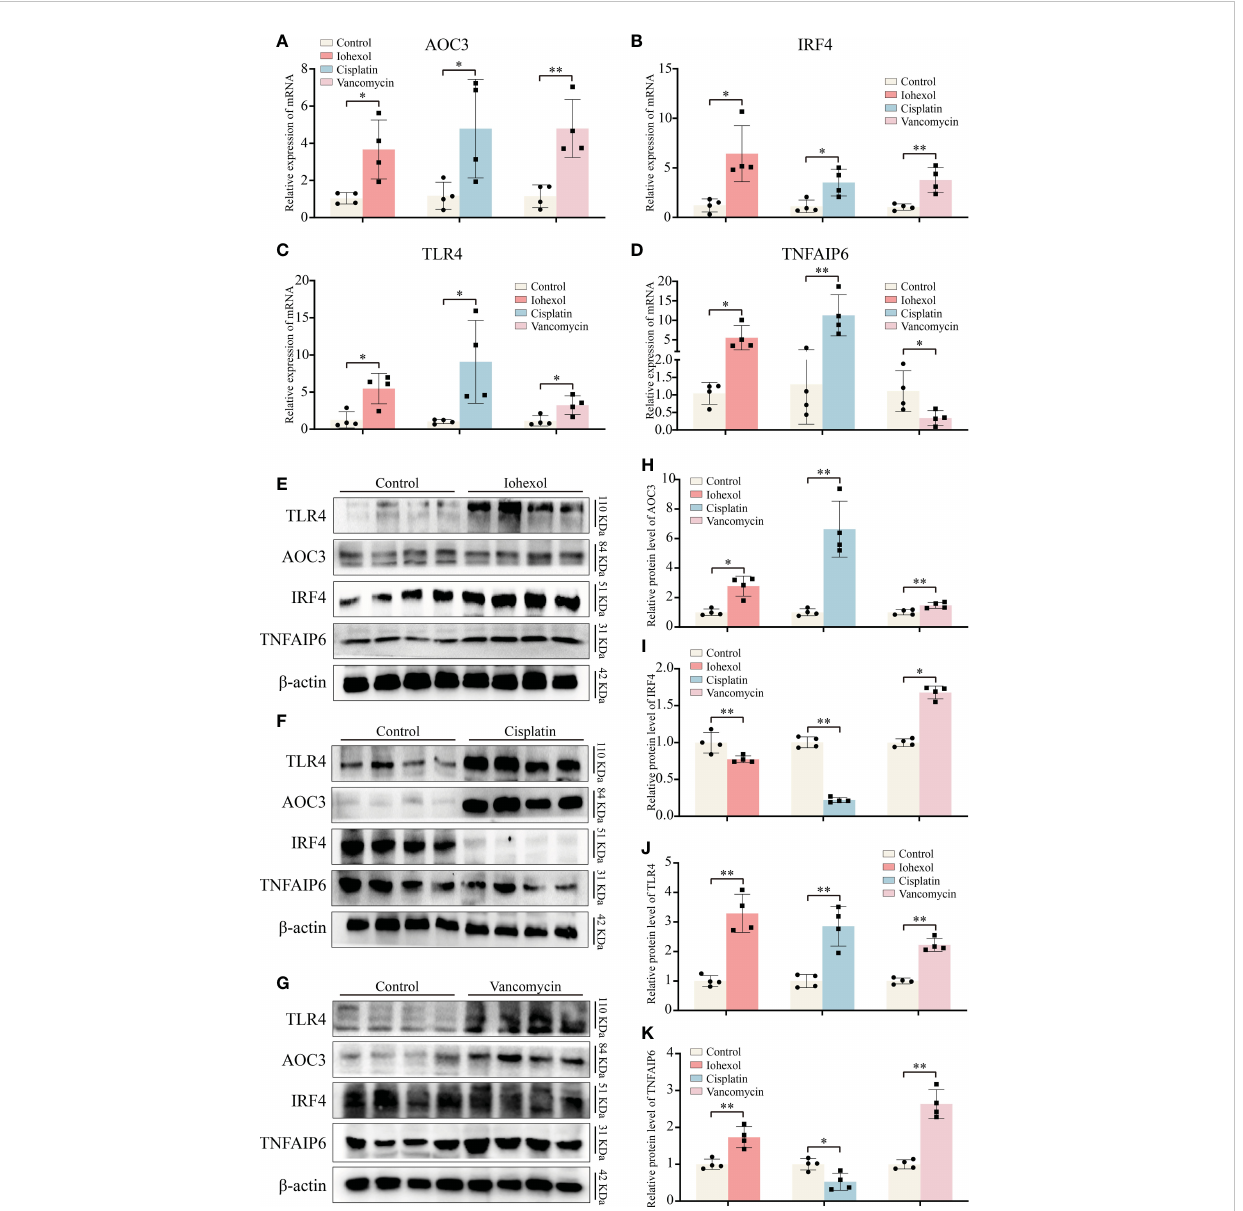
FIGURE 7 Validation of hub genes in vivo . (A – D) The mRNA expression level of AOC3, IRF4, TLR4 and TNFAIP6 in renal tissue of iohexol, cisplatin or vancomycin induced AKI mice compared with controls. (E – K) The protein expression level of AOC3, IRF4, TLR4 and TNFAIP6 in renal tissue of iohexol, cisplatin or vancomycin induced AKI mice compared with controls. * p < 0.05; ** p <